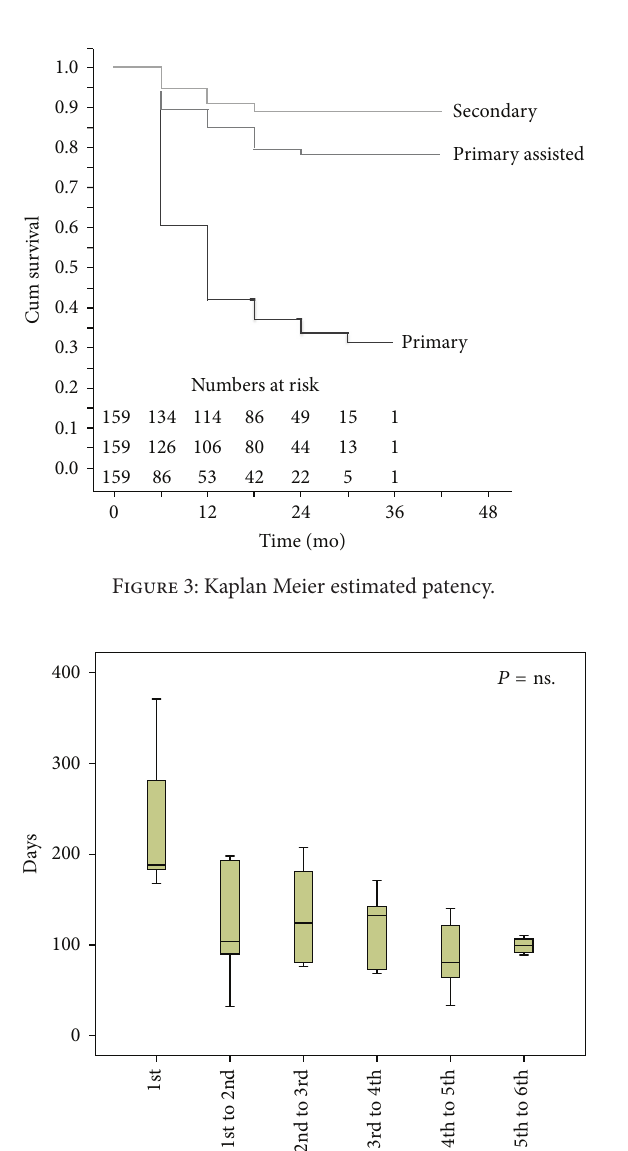
Figure 4: Time intervals between PTAs. Median, IQR in box, and range are given. There was no statistically significant difference between the groups.